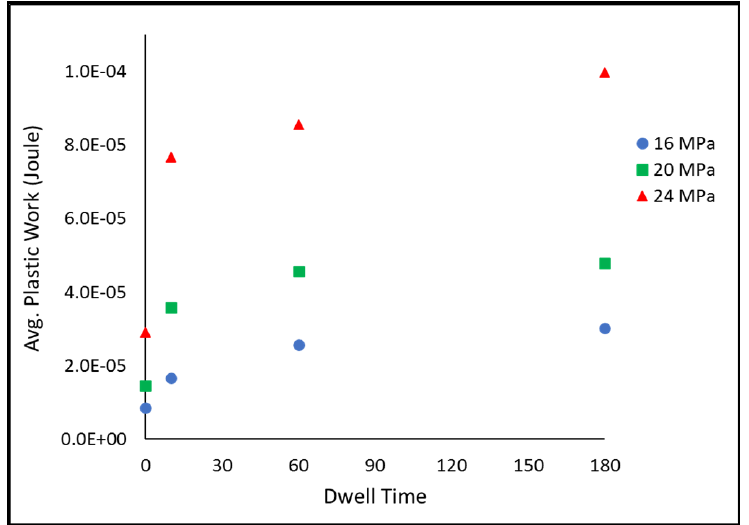
Figure 24. Average work per cycle as a function of dwelling times at various stress levels.